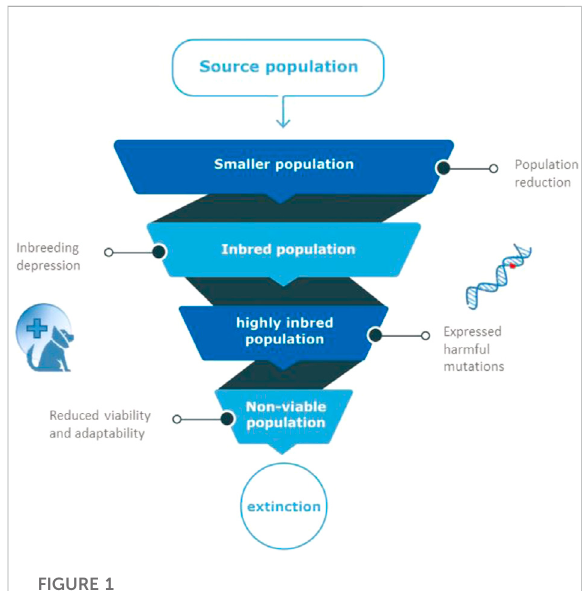
FIGURE 1 The extinction vortex. When population size is reduced, related animals produce inbred offspring. Inbred animals will have reduced fertility and survival because of harmful mutations that appear in homozygous state in inbred individuals (inbreeding depression). Due to the fi xationof such harmful mutations in small populations, overall viability of the population is reduced, leading to more inbreeding, a non-viable population and eventual